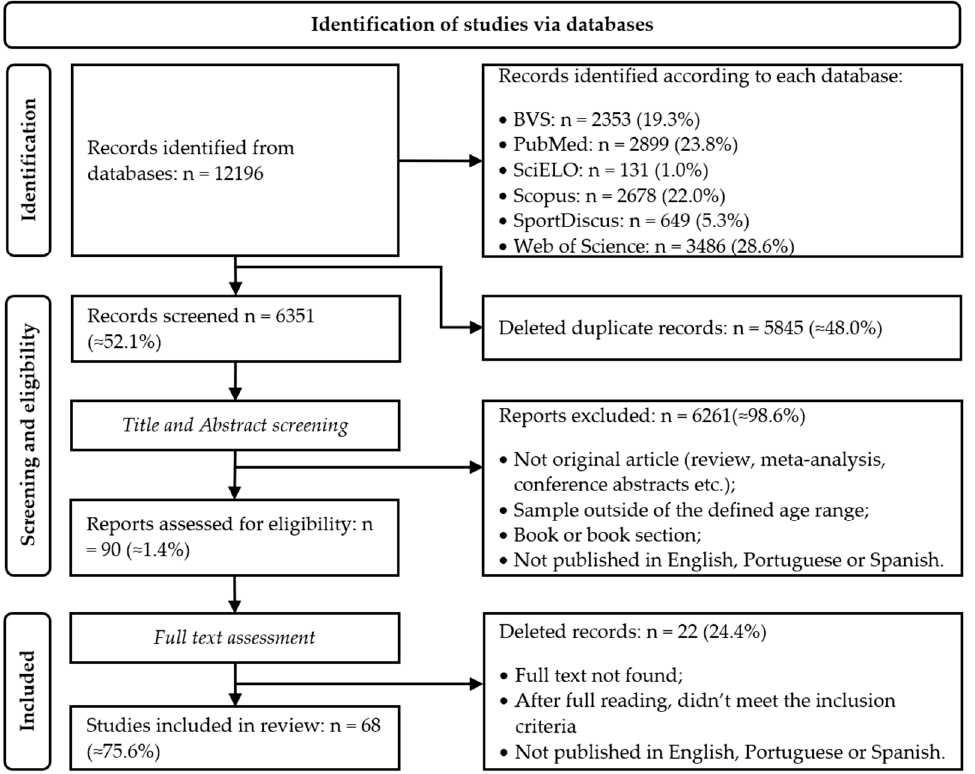
Figure 1. Flowchart for data screening (adapted from PRISMA 2020 flow diagram [24]).